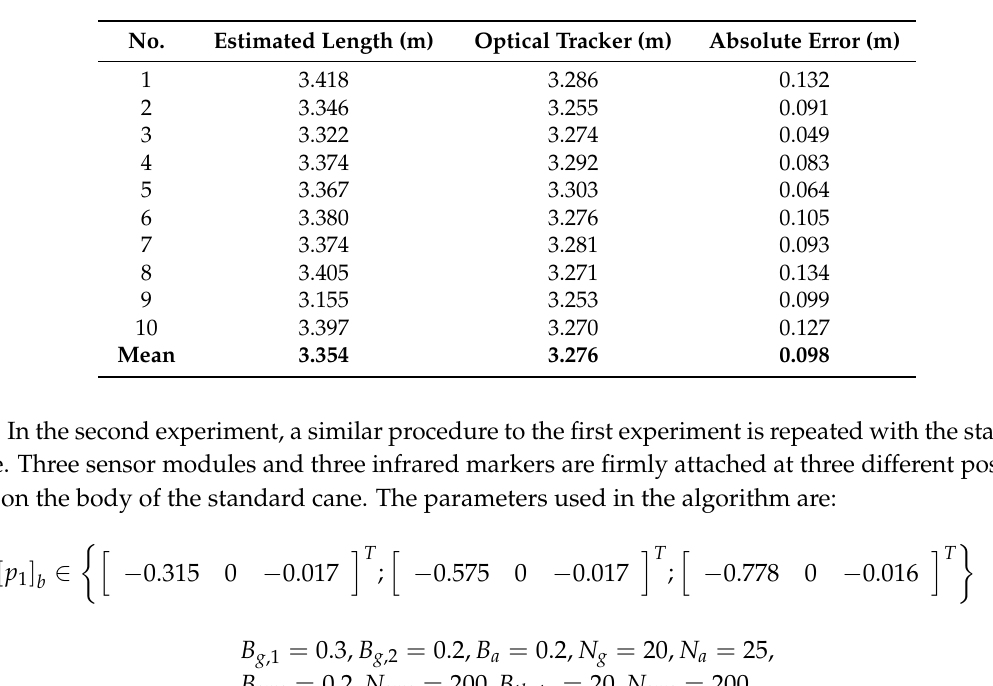
Table 1. Quadripod cane’s estimated and reference walking distance.